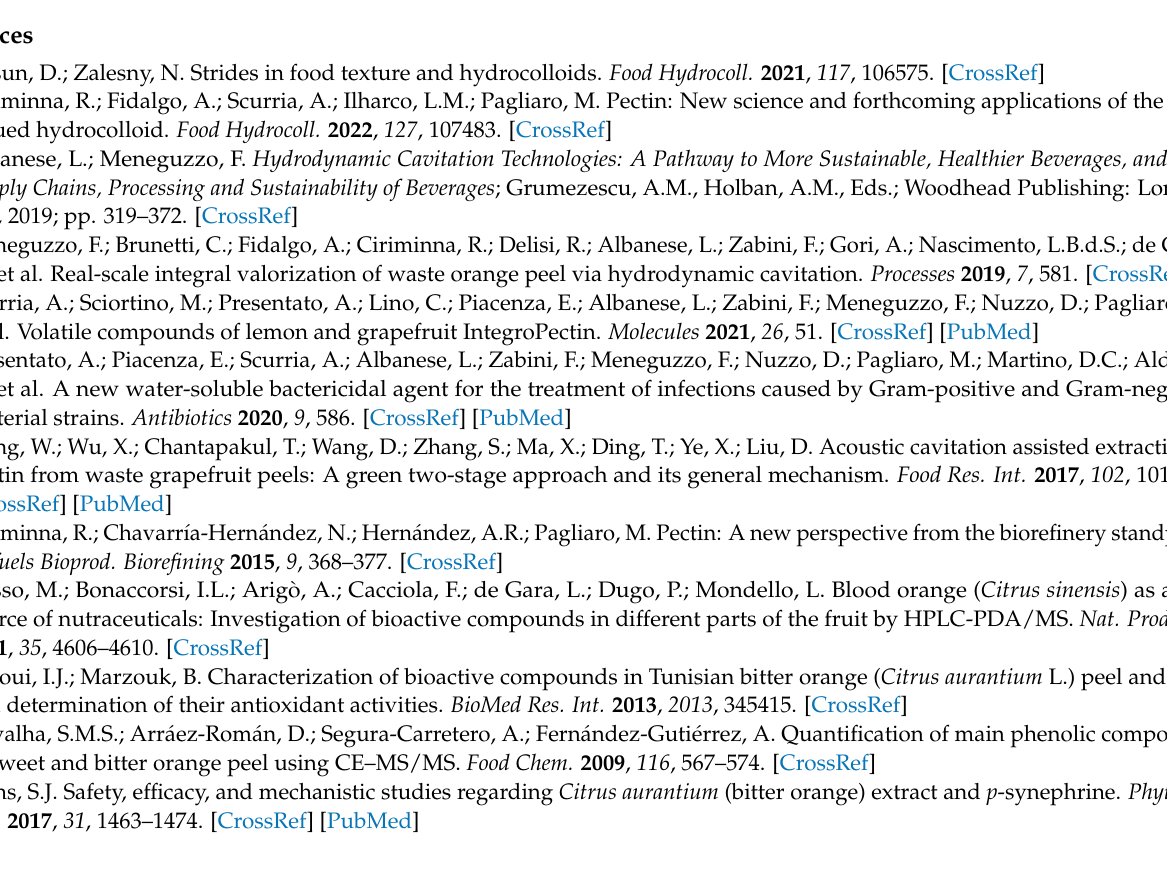
Figure S2. Chromatogram of bitter orange IntegroPectin extract. Figure S3. Bitter orange IntegroPectin extract: mass spectra of naringenin (a), naringin (b), and eriocitrin (c). Figure S4. Bitter orange IntegroPectin extract: mass spectra of hesperidin (a), and caffeic acid (b). Figure S5. Chromatogram of red orange IntegroPectin. Figure S6. Red orange IntegroPectin extract: mass spectra of naringin (a), gallic acid (b), and hesperidin